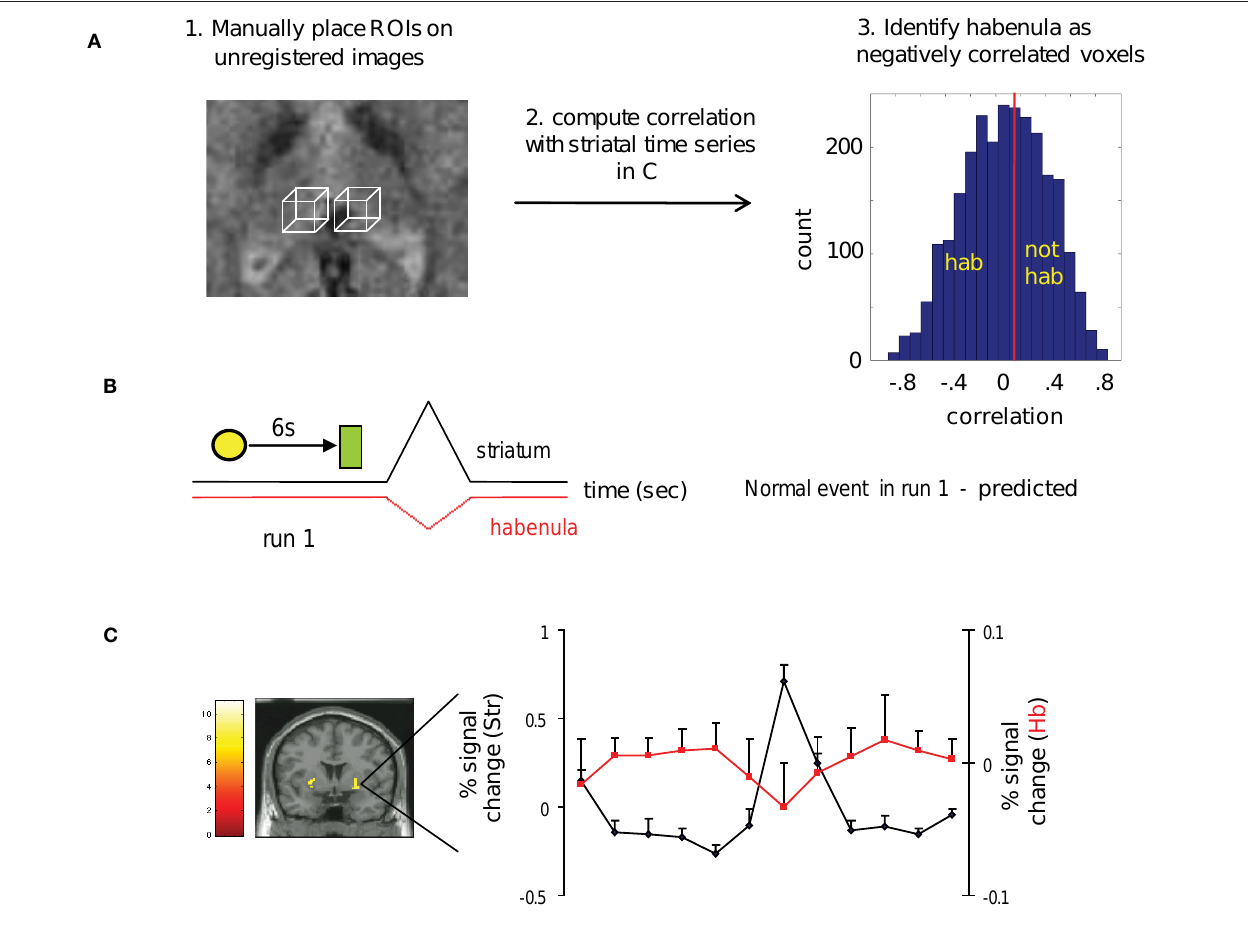
FIguRe  | Anti-correlation approach to identify habenula-containing voxels. (A) Identifying habenula voxels. Step 1. Place two 27-voxel bounding boxes by hand over a region containing each habenula using unregistered images. Step 2. Compute the correlation between the average striatal time series and the time series from each of those 54 voxels. Step 3. From the 2700 correlations generated (blue histogram), define habenula voxels as those to the left of the median (red line) of the distribution ( ∼ 0.1 correlation). Other analogous decision criteria also suffice. Voxels accepted as habenula are identified by anti- correlation with the striatal time series whose identification is described below. (B) Predicted habenula and striatal responses to an early passive conditioning trial (normal event in run 1) based on electrophysiological data from non-human